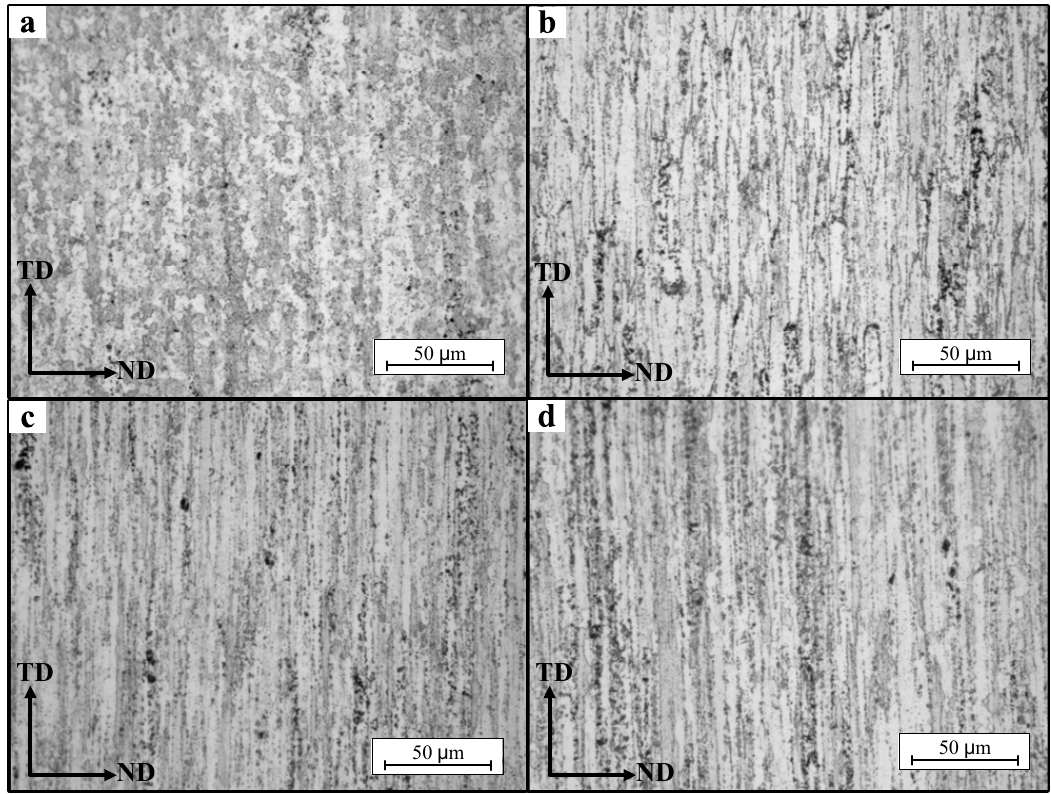
Figure 8. OM images of ND-TD surface for ( a ) 7075 Al; ( b ) 0.15 wt % rGO/7075 Al; ( c ) 0.30 wt % rGO/7075; and ( d ) 0.50 wt % rGO/7075.